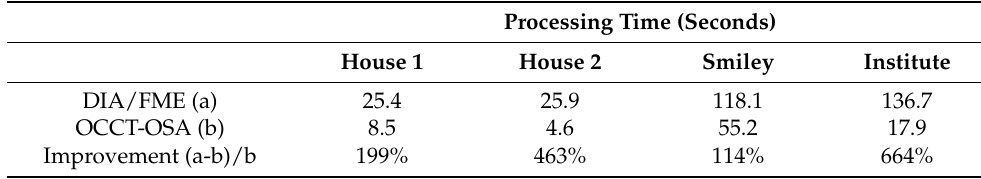
Table 10. Processing time between OCCT-OSA and DIA/FME.